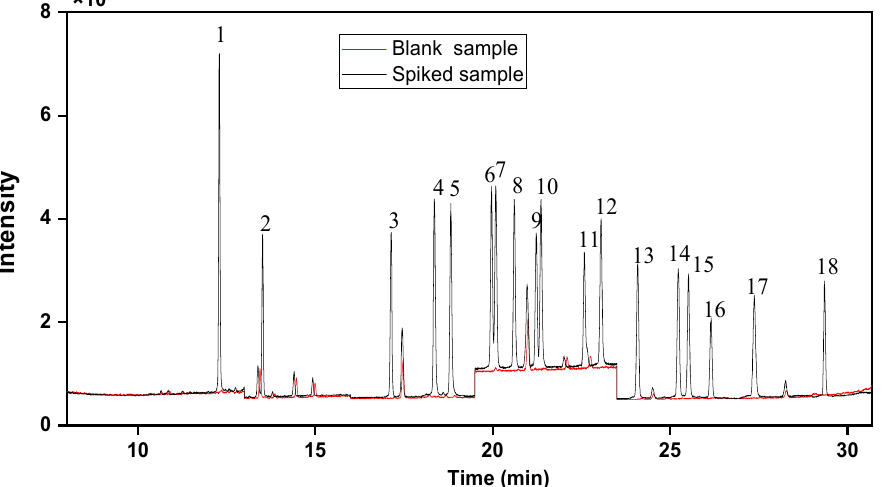
Figure 7. SIM chromatograms of a blank corn sample (red) and a spiked corn sample at 10 μ